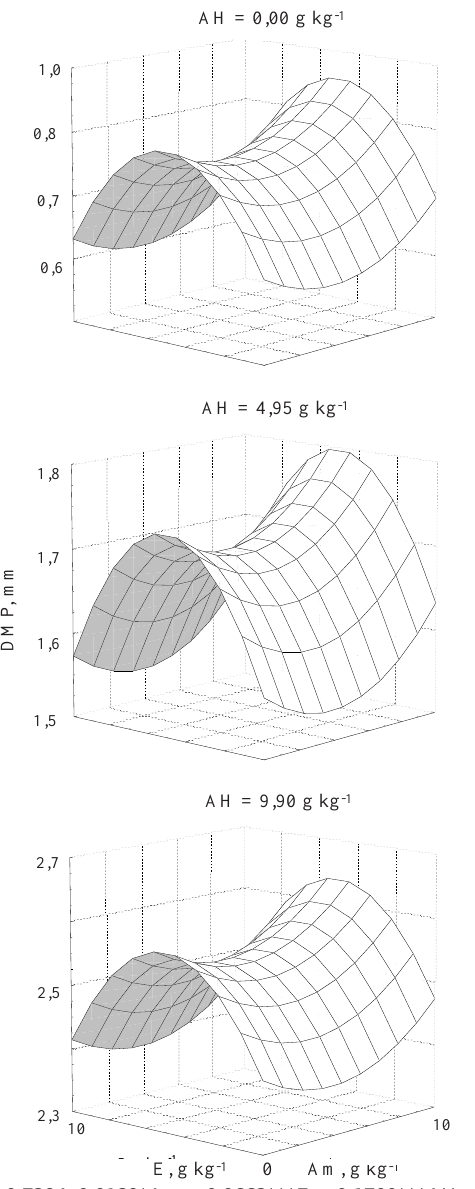
Figura 6. Diâmetro médio geométrico (DMG) dos agregados do horizonte A analisado por via úmida, considerando a adição de amido (Am) e ácido esteárico (E), para diferentes doses de ácido húmico (AH).